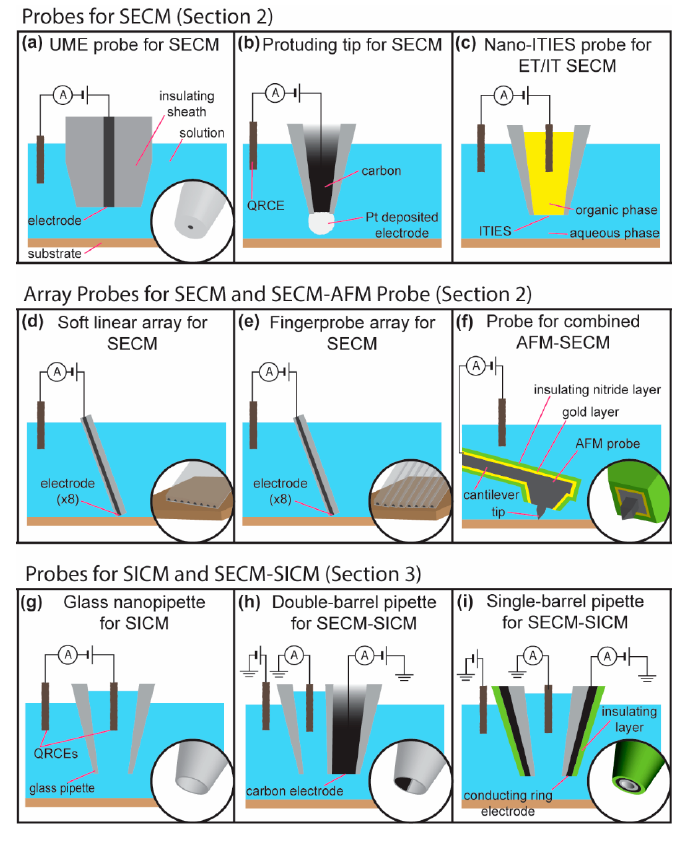
Figure 1. Schematics showing cross-sections of various probes typically used in